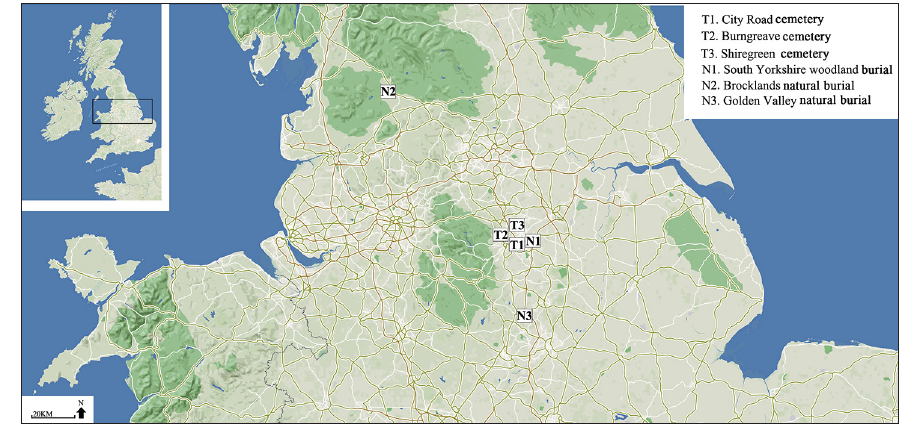
Figure 1. Study site locations (adapted from Mapbox, 2018)